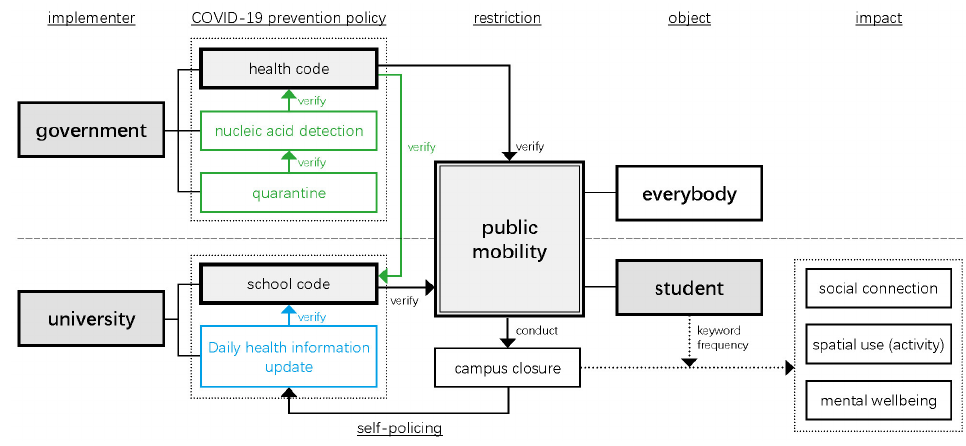
Figure 10. Illustration of current self-policing management on campus.